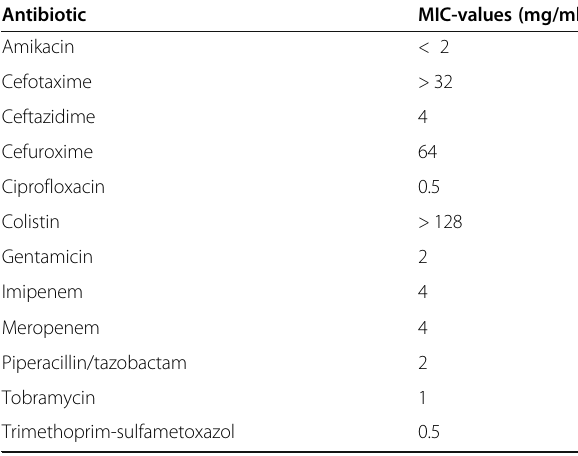
Table 2 Minimum inhibitory concentration (MIC) values for Burkholderia contaminans